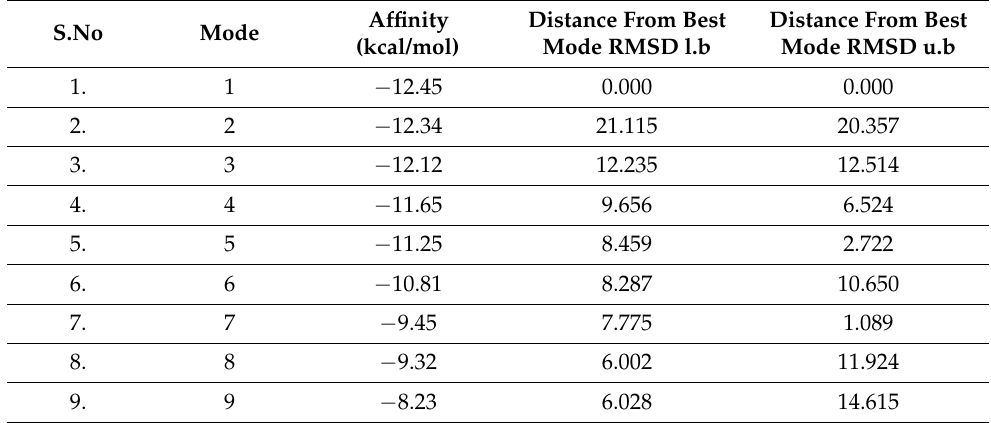
Table 6. Docking result of quercetin against CALHM1.